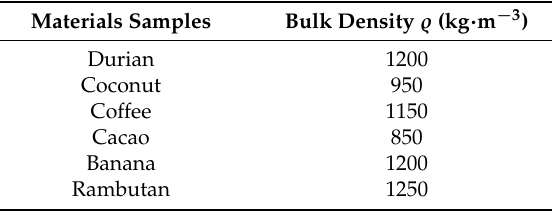
Table 11. Maximal advantageous bulk density of bio-briquette